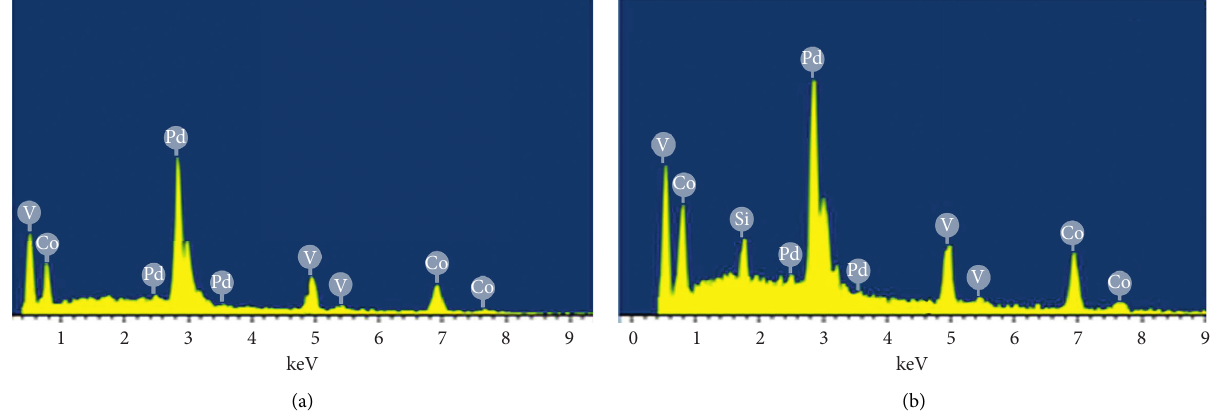
Figure 2: EDX spectra of nanocatalysts: (a) PdVCo-15EG-20NaBH